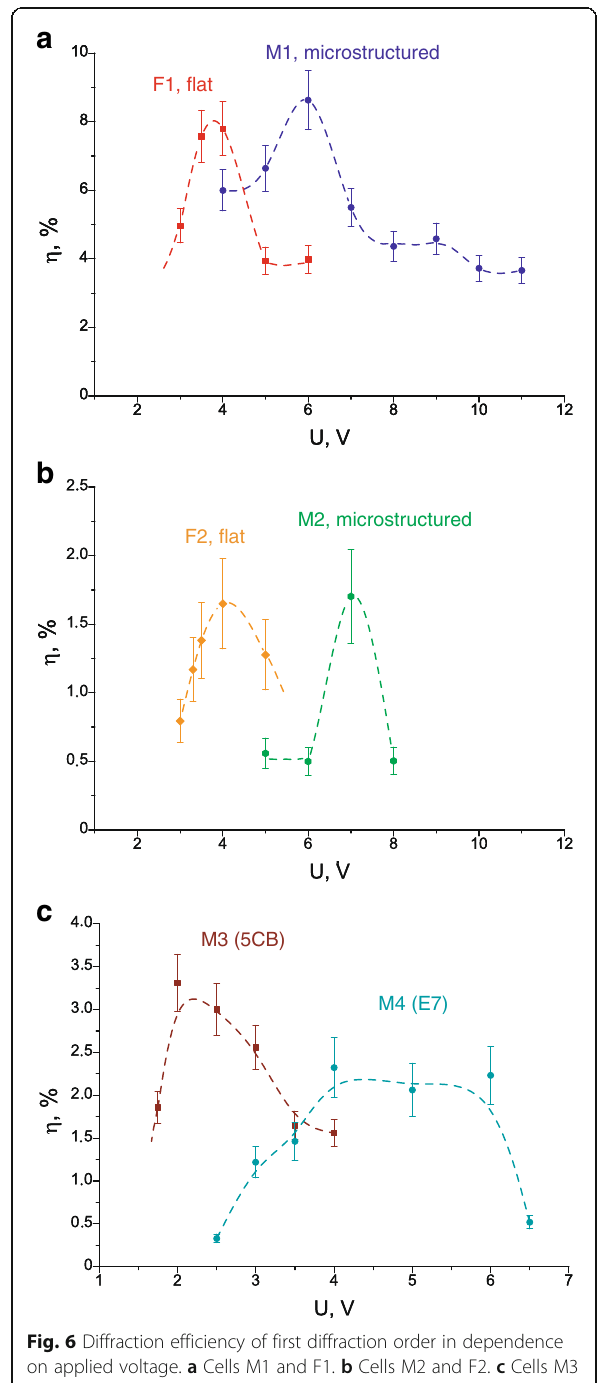
Fig. 6 Diffraction efficiency of first diffraction order in dependence on applied voltage. a Cells M1 and F1. b Cells M2 and F2. c Cells M3 and M4. Dashed lines presented for the visualisation